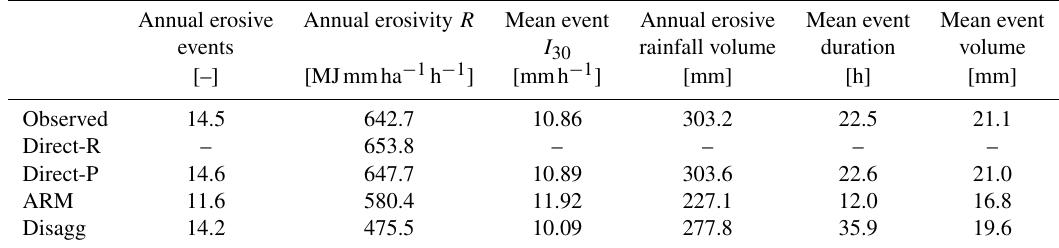
Figure 9. Relative bias of all stations ( N = 32) for all realisations ( N = 20) and density scenarios ( N = 5) for different erosive event variables (for each box plot, N = 3200). Annual number of erosive events, annual number of all erosive event volume, erosive event duration, maximum event I 30 rainfall intensity, and erosive event volume are shown. Outliers are excluded for clarity. Table 1. Median values over all reference stations ( N = 32) and realisations ( N = 20). Simulated values are given for the 100% density scenario. Annual erosive Annual erosivity R Mean event Annual